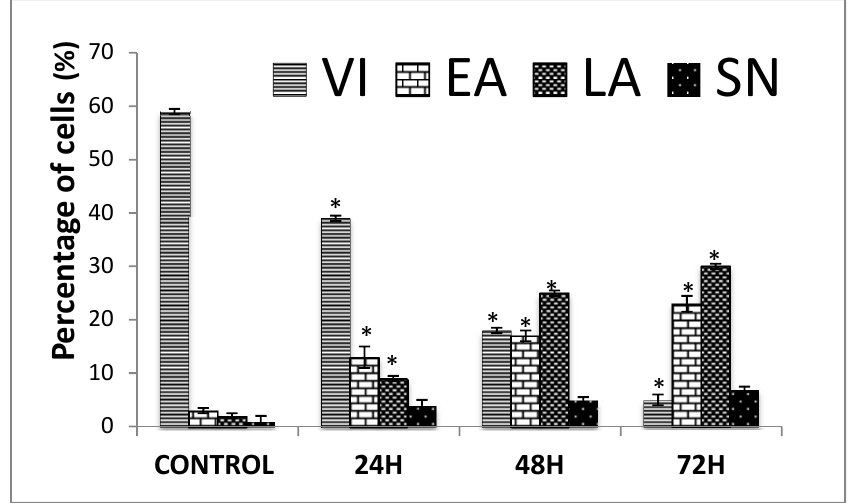
Figure 3. Percentages of viable, early apoptotic, late apoptosis and secondary necrotic cells after thymoquinone treatment. CEMss cell death via apoptosis increased significantly (* p < 0.05) in a time-dependent manner. However, no significant ( p > 0.05) difference was observed in the cell count of necrosis. VI: viable Cell, EA: Early apoptosis, LA: late apoptosis, SN: secondary